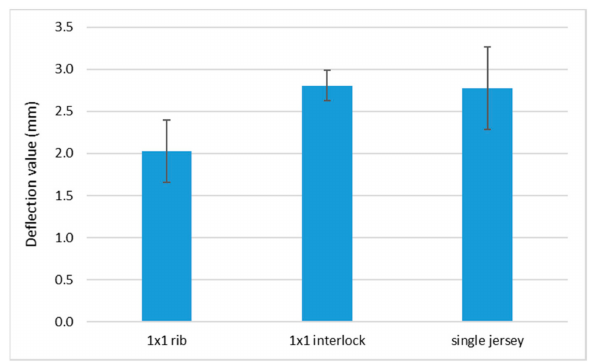
Figure 15. Deflection values of the POF at the back of the slider for the three fabrics.